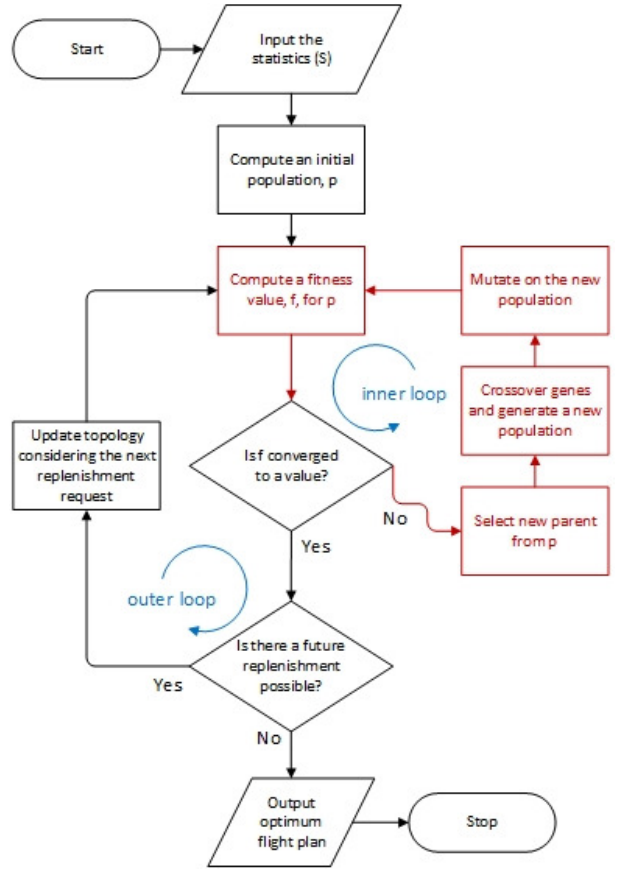
Figure 6. Flowchart for flight path planner implementation.